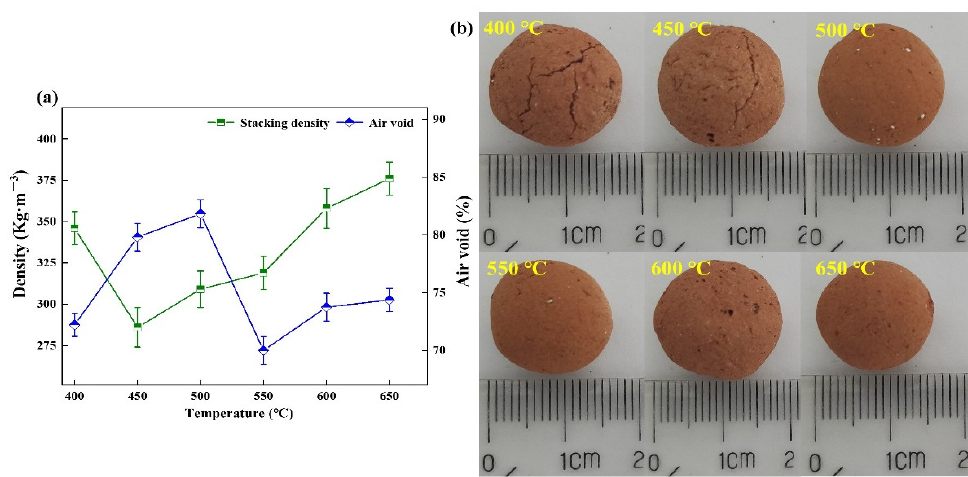
Figure 4. Effect of low temperature pyrolysis temperature on the pore structure of ceramsite (( a ) is stacking density and air void, ( b ) is ceramsite prepared by low temperature pyrolysis) .